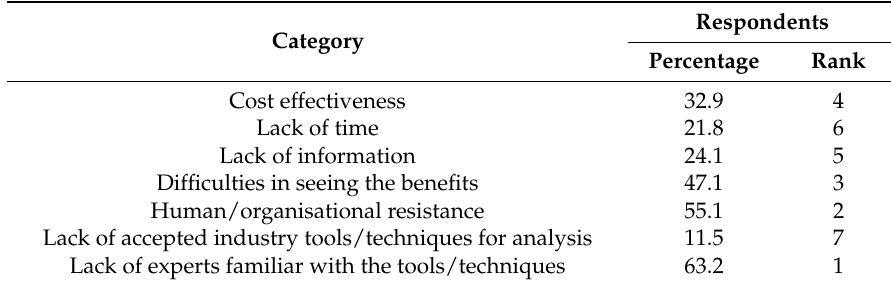
Table 7. Factors limiting implementation of risk